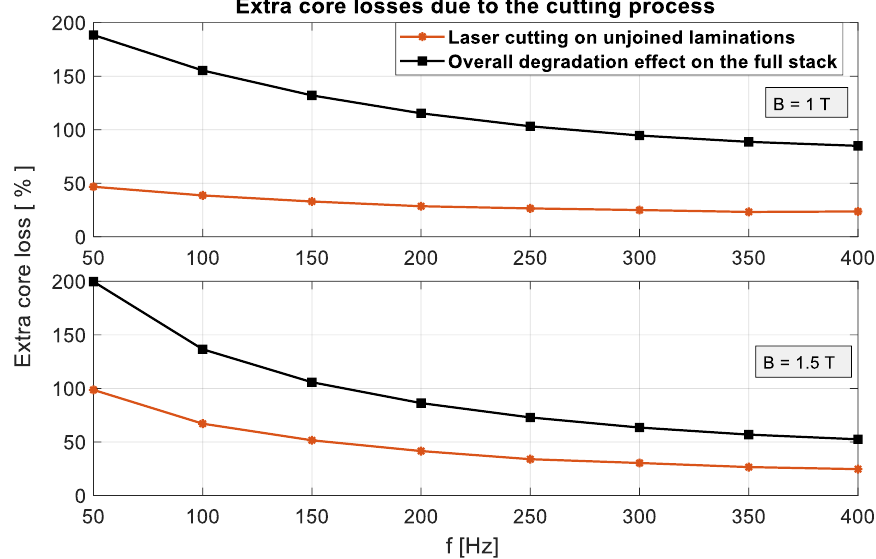
Figure 18. Extra core losses (in %Percent) due to steel cutting on the full stack core compared to the un-joined laminations.